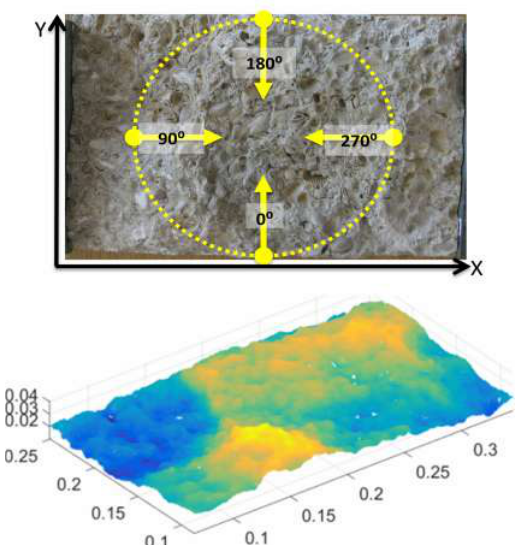
Figure 2. The sample of 20×30 cm rock joint formed in fossiliferous limestone with indicted analysis direction (top) and sample’s ATOS point cloud; coordinates are given in meters